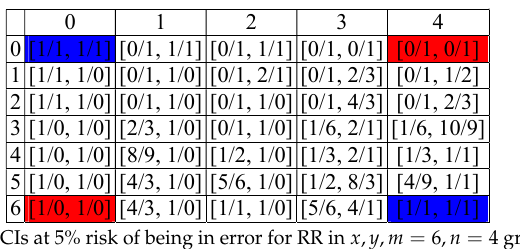
Figure 7. CI RR,5% (0..6, 0..4, 6, 4).